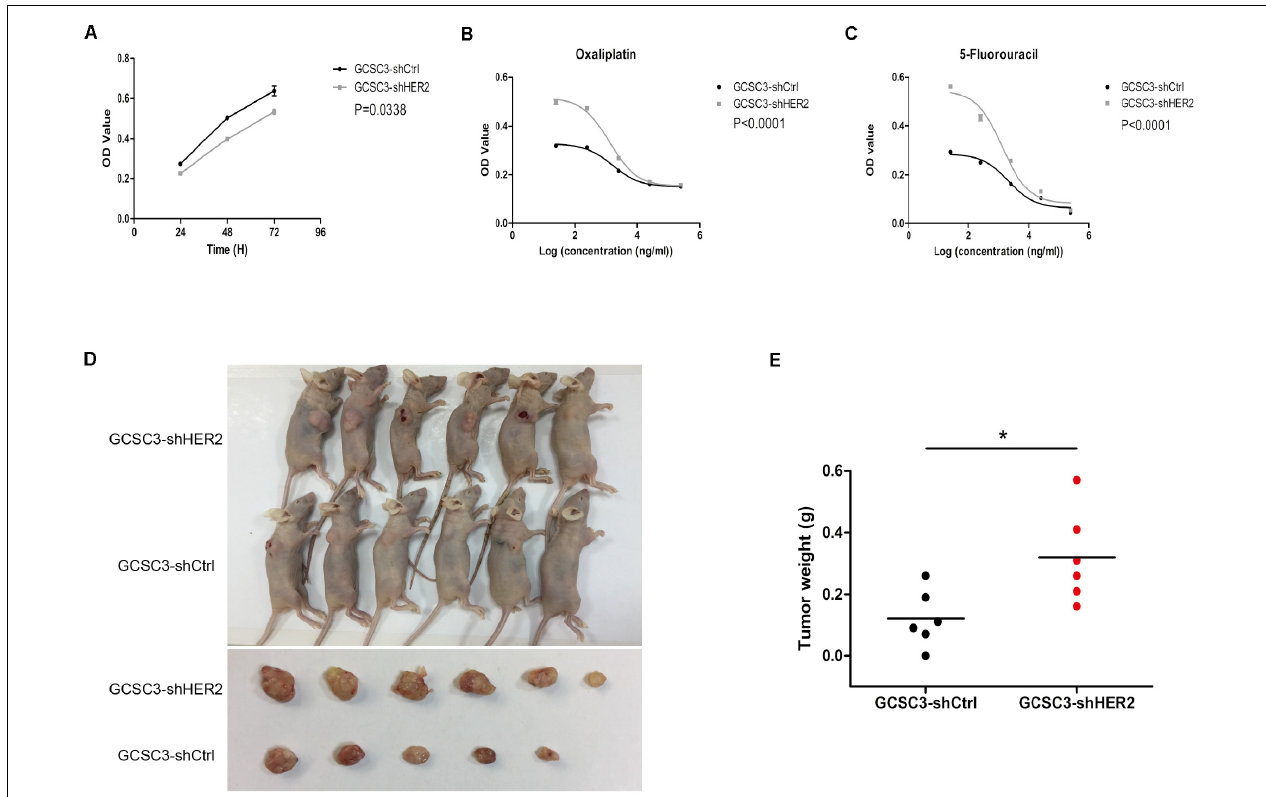
FIGURE 4 | The results of CCK-8 assay, chemotherapy sensitivity, and xenograft models of GCSCs. Picture (A) shows that down-regulation of HER2 could decrease the proliferation of GCSCs ( p = 0.0338). Data were expressed as mean ± SEM. Pictures (B,C) show that the chemotherapy sensitivity for oxaliplatin and 5-fluorouracil was increased after HER2 interference ( p < 0.0001). Pictures (D,E) show that tumor weight in the GCSC3-shCtrl group was significantly lower than that in the GCSC3-shHER2 group (0.12 ± 0.04 g vs. 0.32 ± 0.06 g, p = 0.0192), * p < 0.05.